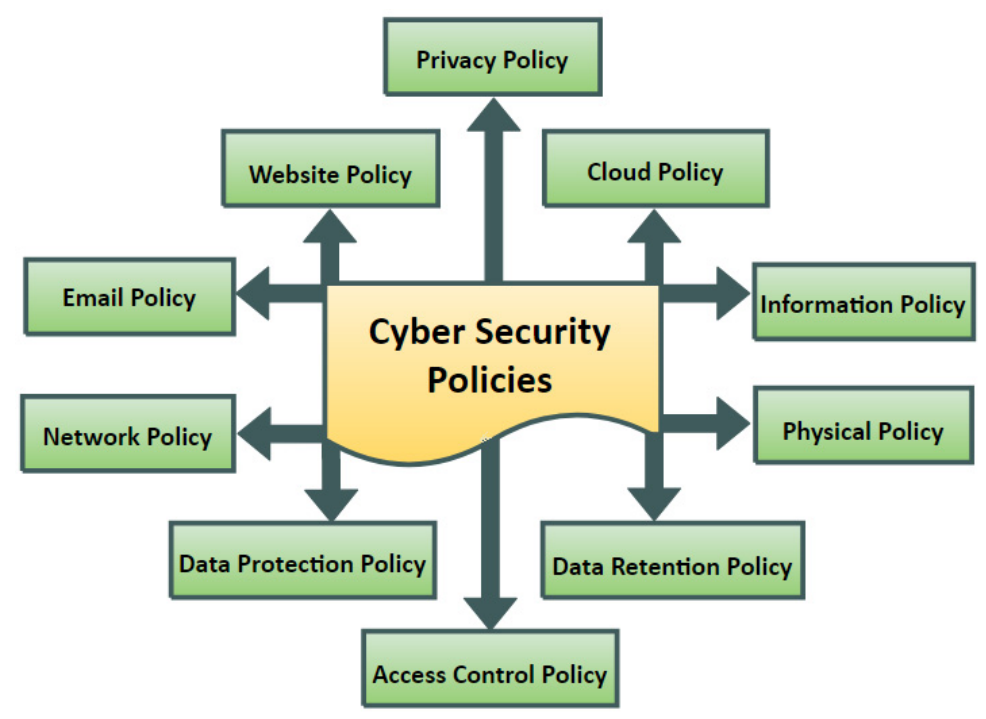
Figure 1. Cybersecurity policies taxonomy.